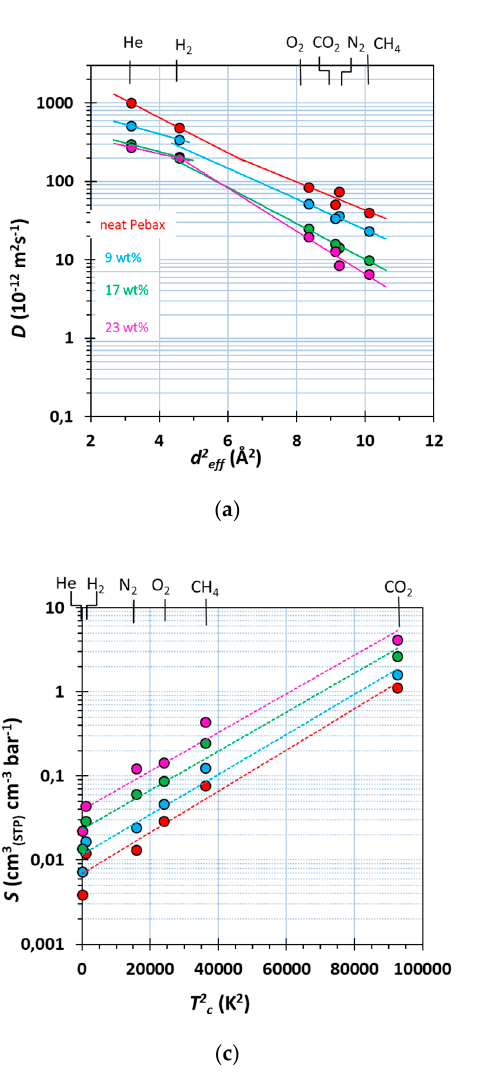
Figure 7. Correlation of the e ff ective di ff usion coe ffi cient as a function of the molecular diameter of six light gases in ( a ) Pebax ® 1657 / CuNi MMMs and ( b ) PEEK-WC / CuNi MMMs. Correlation of the e ff ective solubility coe ffi cient of the gases as a function of their critical temperature in ( c ) Pebax ® 1657 / CuNi MMMs and ( d ) PEEK-WC / CuNi MMMs. The legend is identical in all individual graphs. ® Contrary to the glassy PEEK-WC, the rubbery Pebax 1657 / CuNi-MOF (23 wt %) membrane shows essentially pressure-independent permeability and selectivity (Figure 8a), after only a slight increase in permeability with pressure in the first run, apparently due to a certain conditioning of the sample. The transport properties of the Pebax-based membrane are dominated by the rubbery phase, and the dispersed MOFs only provide a higher gas sorption capacity in the membrane but do not significantly a ff ect the overall